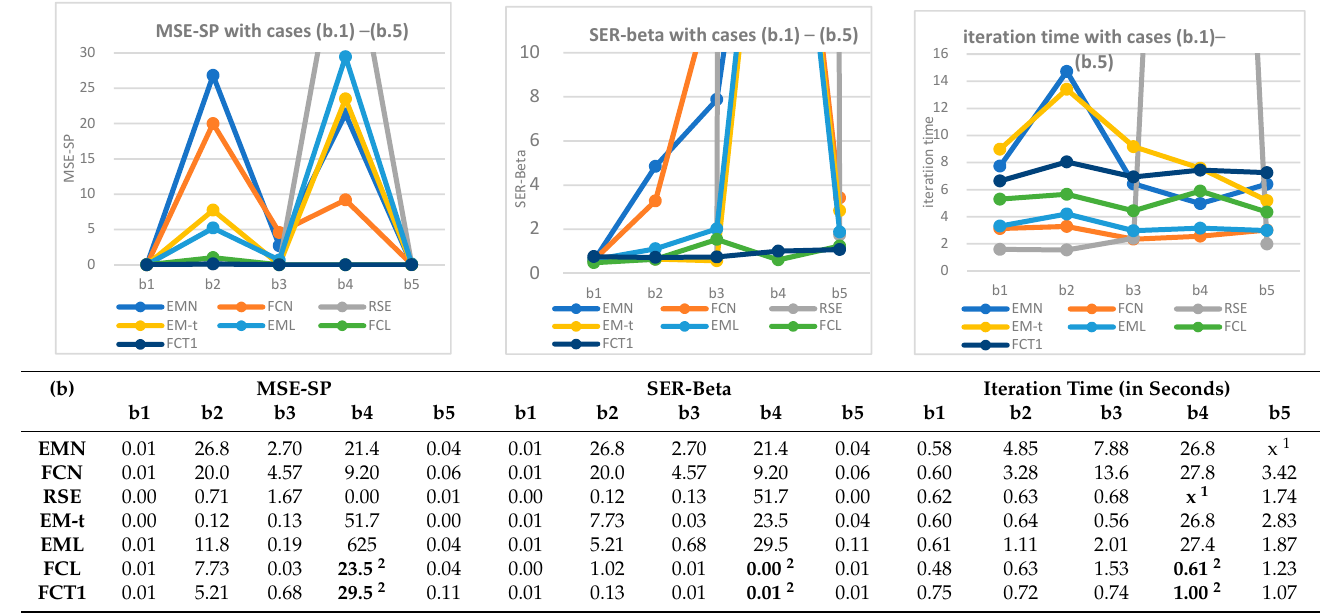
1 : the value is extremely large, 2 : the results of FCL and FCT1 in case b4 with an extremely high- leverage outlier at (20,100) are derived from the trimmed FCLtr and FCT1tr with the cut percentage 0.1 α= .